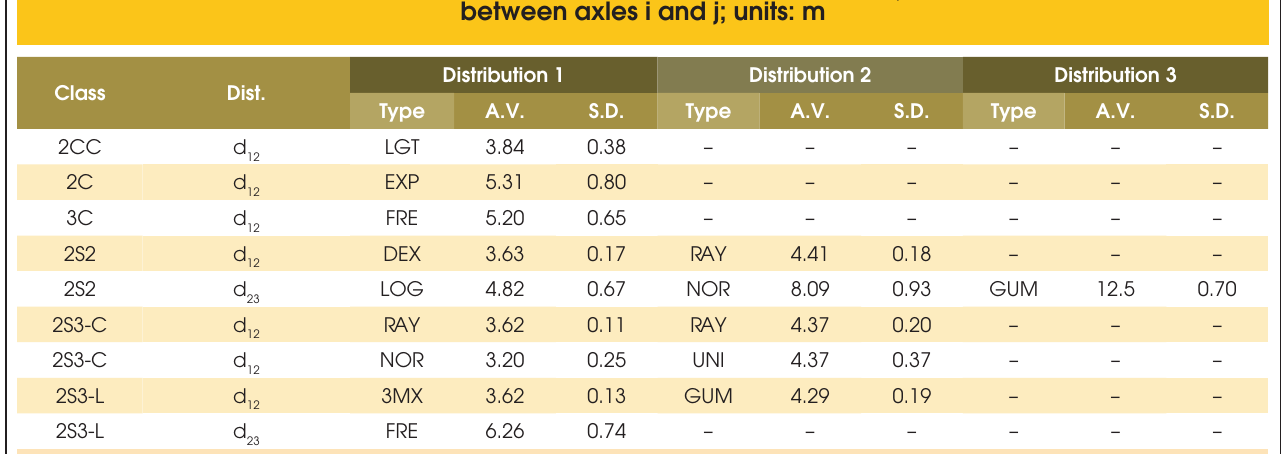
is the distance ij